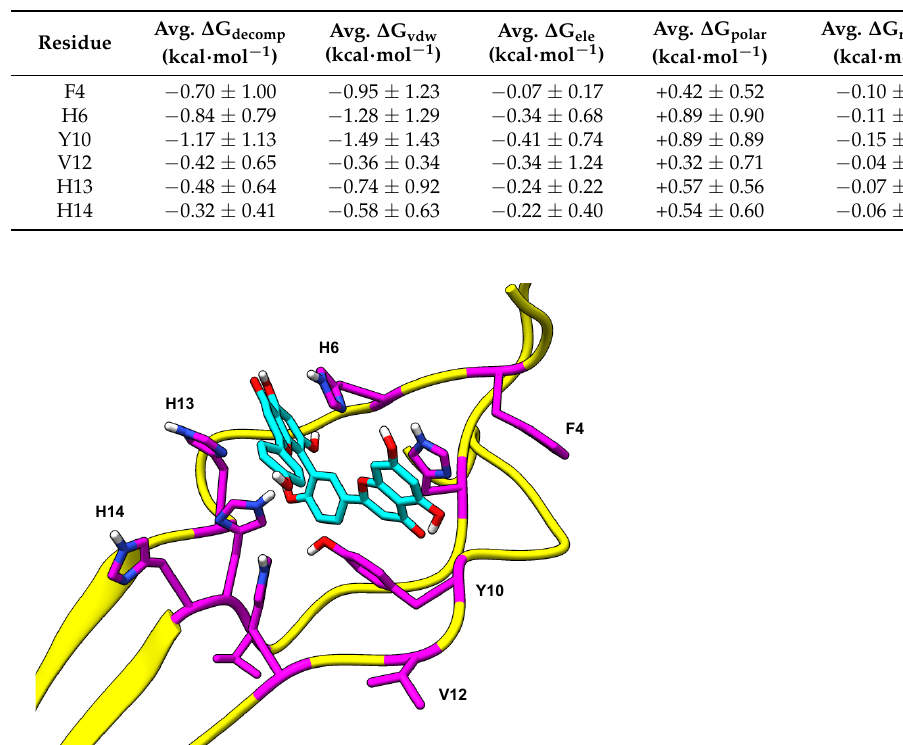
Table 1. ∆ G decomp , ∆ G vdw , ∆ G ele , ∆ G polar , and ∆ G nonpolar of primary binding residues averaged Table 1. Δ G decomp , Δ G vdw , Δ G ele , Δ G polar , and Δ G nonpolar of primary binding residues averaged across the five ligand-bound simulations. across the five ligand-bound simulations.